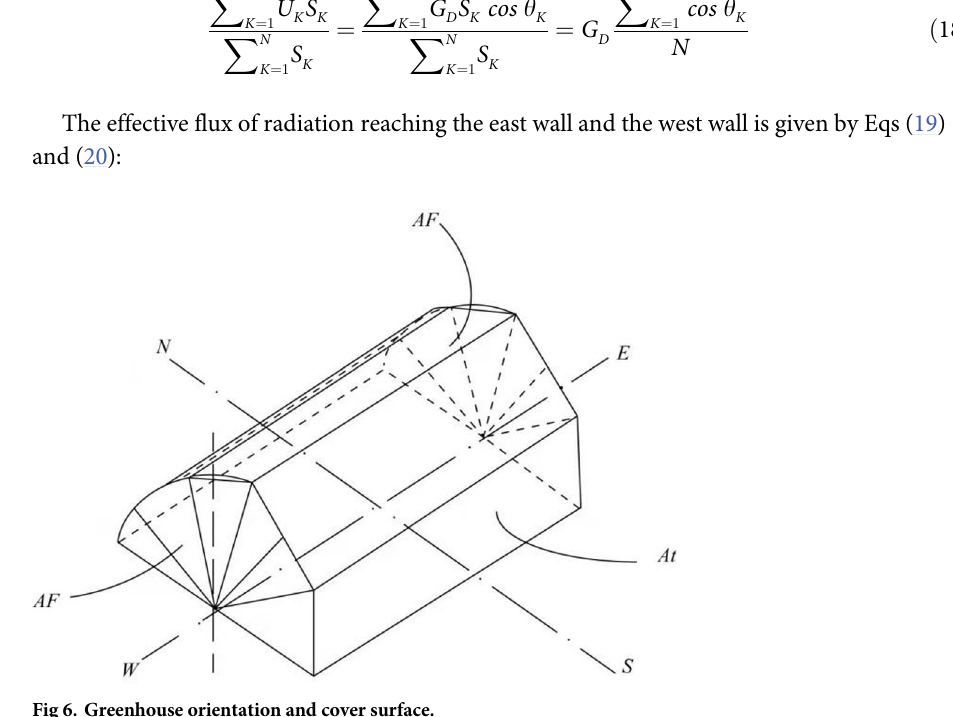
Fig 6. Greenhouse orientation and cover